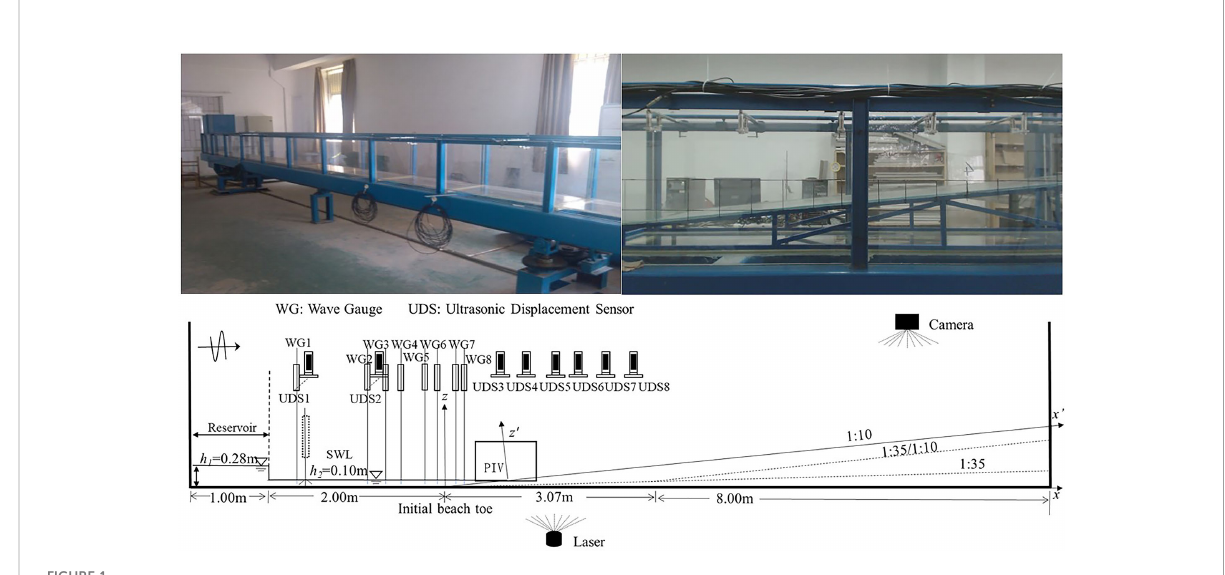
FIGURE 1 Sketch of the experimental setup and measurement